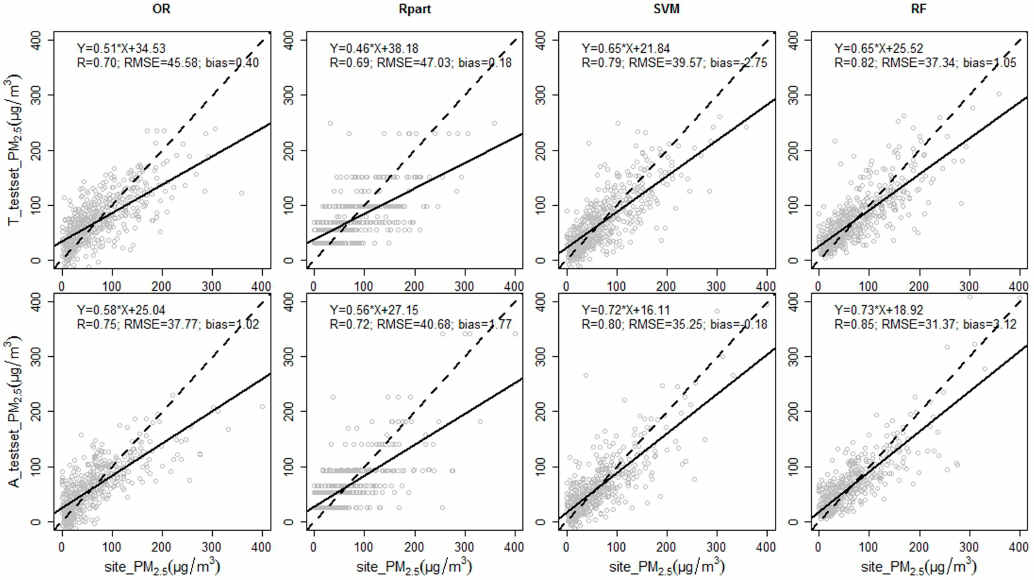
Figure 2. Scatterplots of observed and predicted concentrations of PM 2.5 in test sets for all models. The solid line shows the fitted models for observed and predicted PM 2.5 concentrations. The dashed line is the reference ( y = x ).